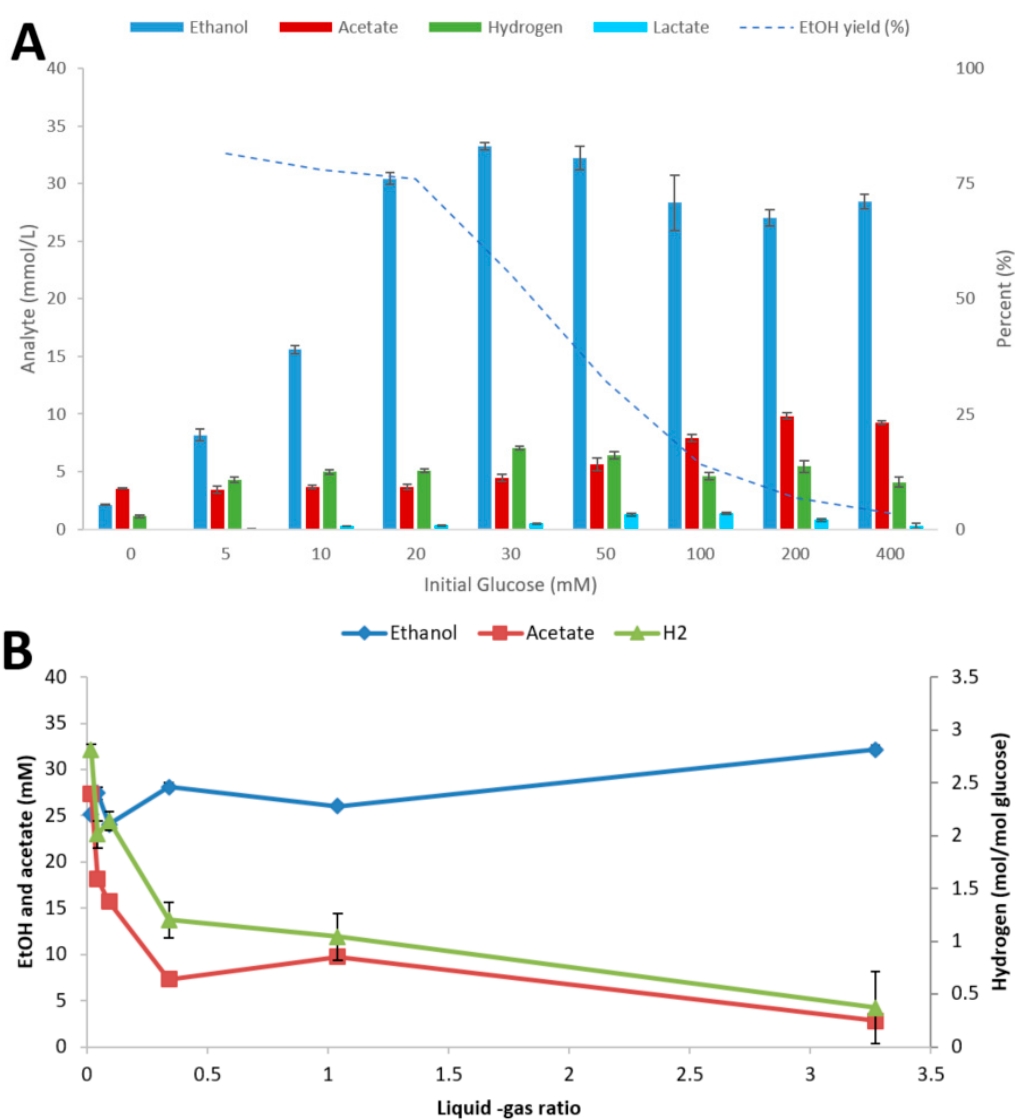
Figure 3. Influence of initial glucose concentration ( A ) and liquid-gas phase ratio (using 20 mM glucose) ( B ) on fermentation by Thermoanaerobacter strain AK152. Fermentations were performed at 65 °C and pH 7.0 with end products being quantified after 5 days. Values represent average ± standard deviation ( n = 3).